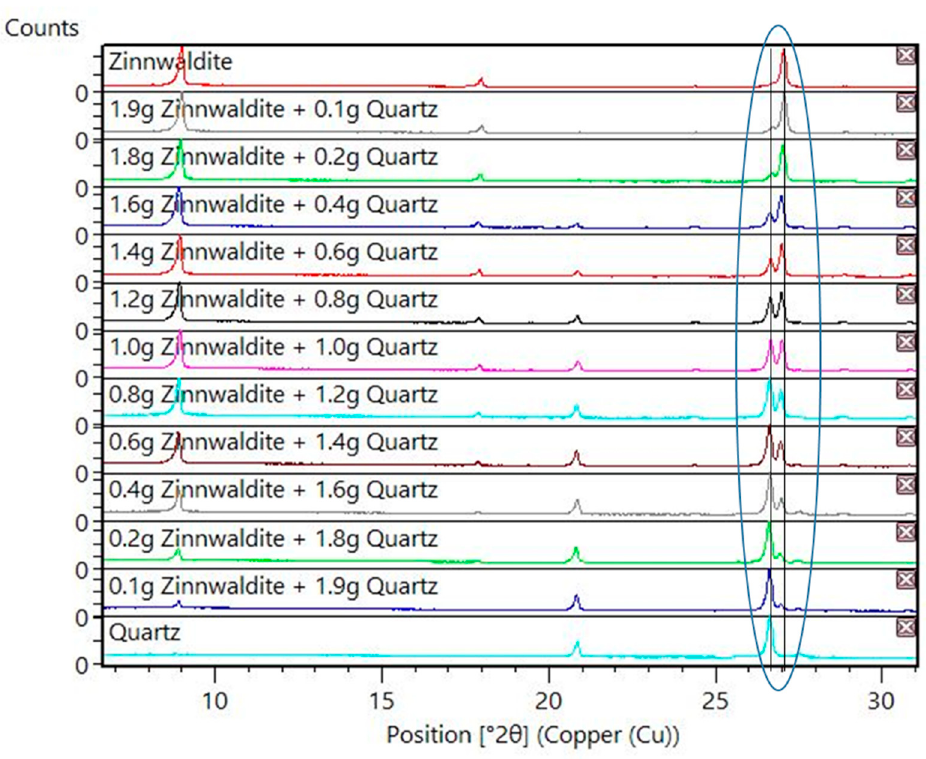
Figure 24. XRD patterns of different zinnwaldite–quartz mixtures with main peaks highlighted.